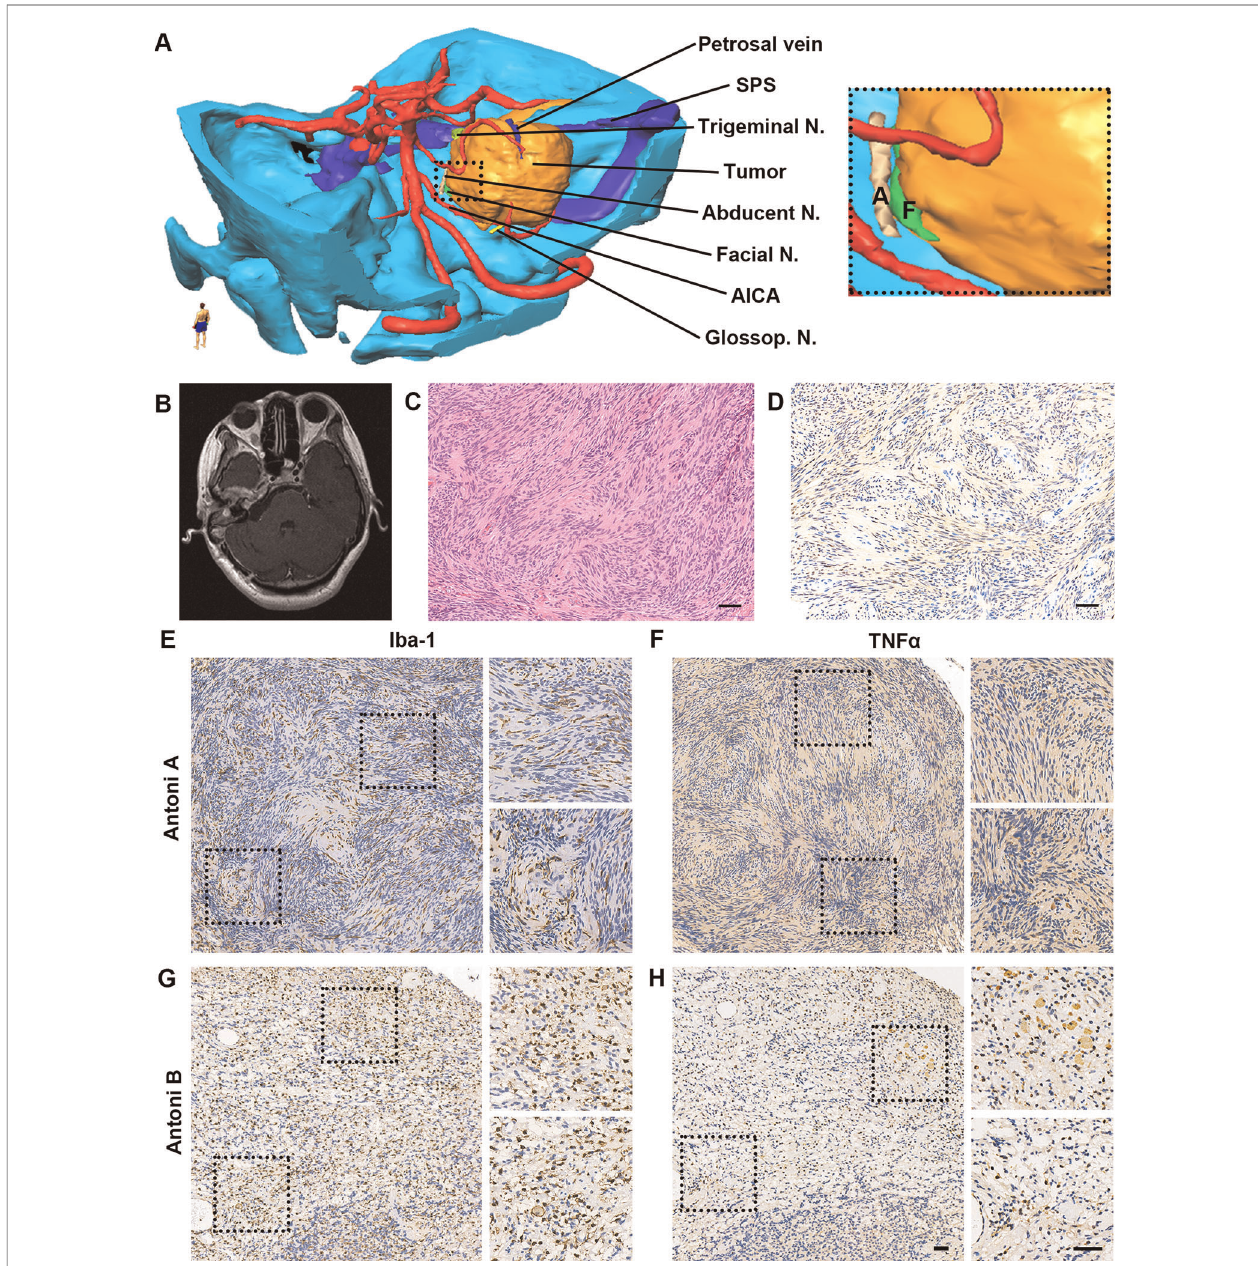
FIGURE 2 | Reconstruction tumor model, imaging scan and pathological examination after surgery. ( A ) Three-dimensional tumor model was reconstructed based on preoperative MRI and CT scan to demonstrate the spatial relationship of the tumor, adjacent nerves, arteries, and veins. ( B ) Postoperative MRI scan exhibited near- total resection of GVS in the posterior cranial fossa. ( C,D ) Pathological examination exhibited typical Verocay bodies in Antoni A region with positive S100 immunoactivity ( C . H&E staining; D . S100b+ cells in IHC. Scale bar, 50 μ m). Abbreviations, AICA, anterior inferior cerebellar artery; N., nerve; SPS, superior petrous sinus. ( E-H ). High immunoactivity of Iba-1 and TNF α in the tumor. ( E ) Iba-1 expression in Antoni A region; ( F ) TNF α expression in Antoni A region; ( G ) Iba-1 expression in Antoni B region; ( H ) TNF α expression in Antoni B region. Scale bar, 50 μ m. Abbreviations, Iba-1, ionized calcium binding adaptor molecule 1; TNF α , tumor necrosis